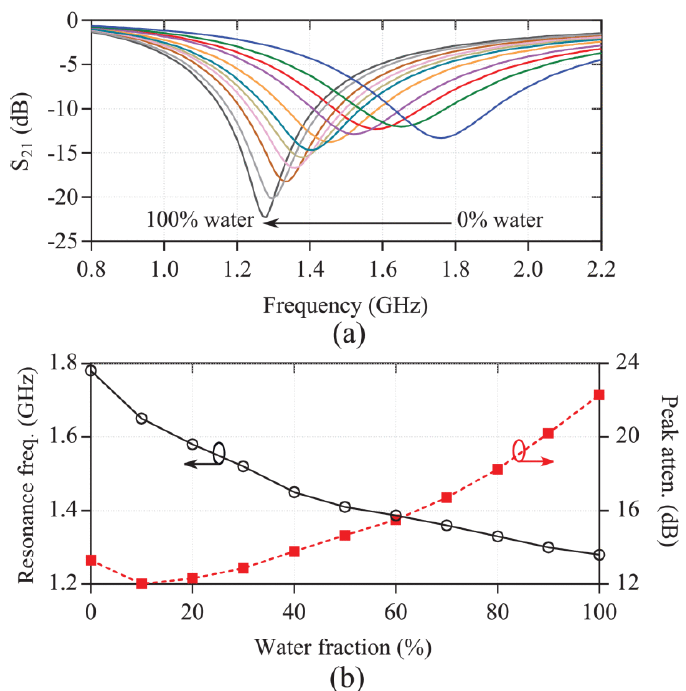
Figure 9. Measured frequency response of the sensor for various water – ethanol solutions ( a ) and representation of the resonance frequency and notch magnitude as a function of the water concentration ( b ). From [46], reprinted with permission. In panel (a), the step variation of water content is 10%.